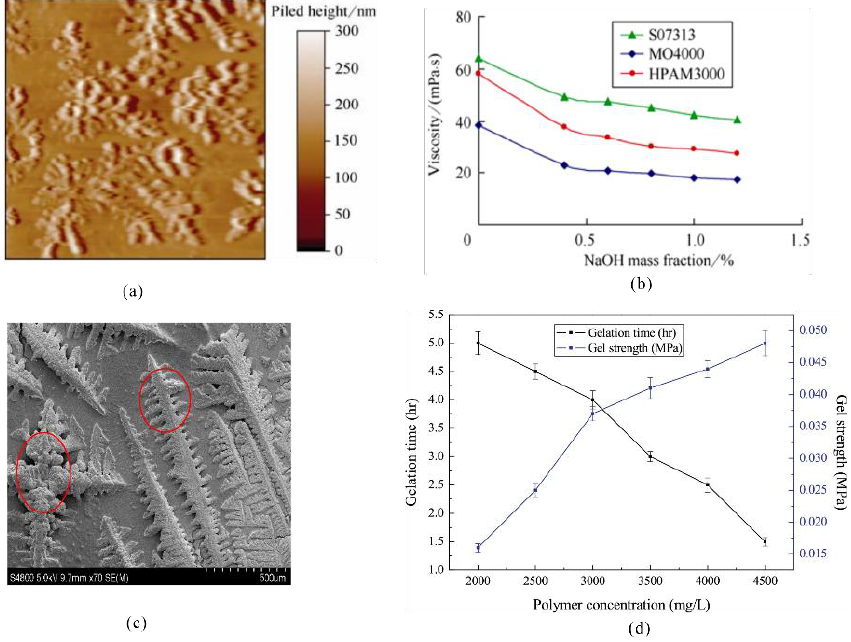
Figure 10. Microstructures of star/comb polymer gels and variations in their properties at different salinities. ( a ) Microscopic image of a star polymer; ( b ) effect of salinity on star polymer viscosity; ( c ) microscopic image of a comb polymer gel; ( d ) crosslinking time and strength of the comb polymer gel at different salinities (Reprinted/adapted with permission from Refs. [66,68]. 2016/2019, Luo, Yang, et al”) .